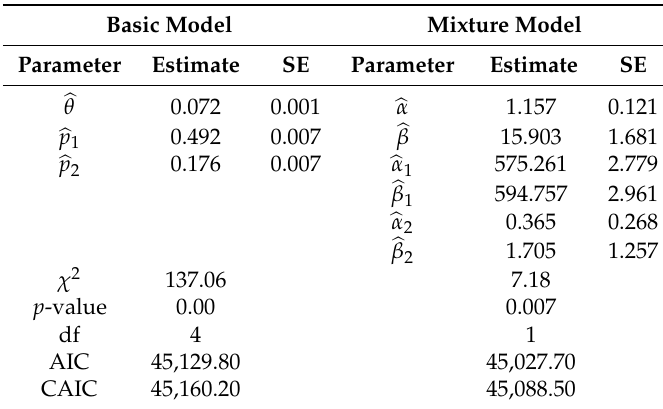
Table 3. Parameters estimated and standard errors (SE) for the basic and mixture model without including